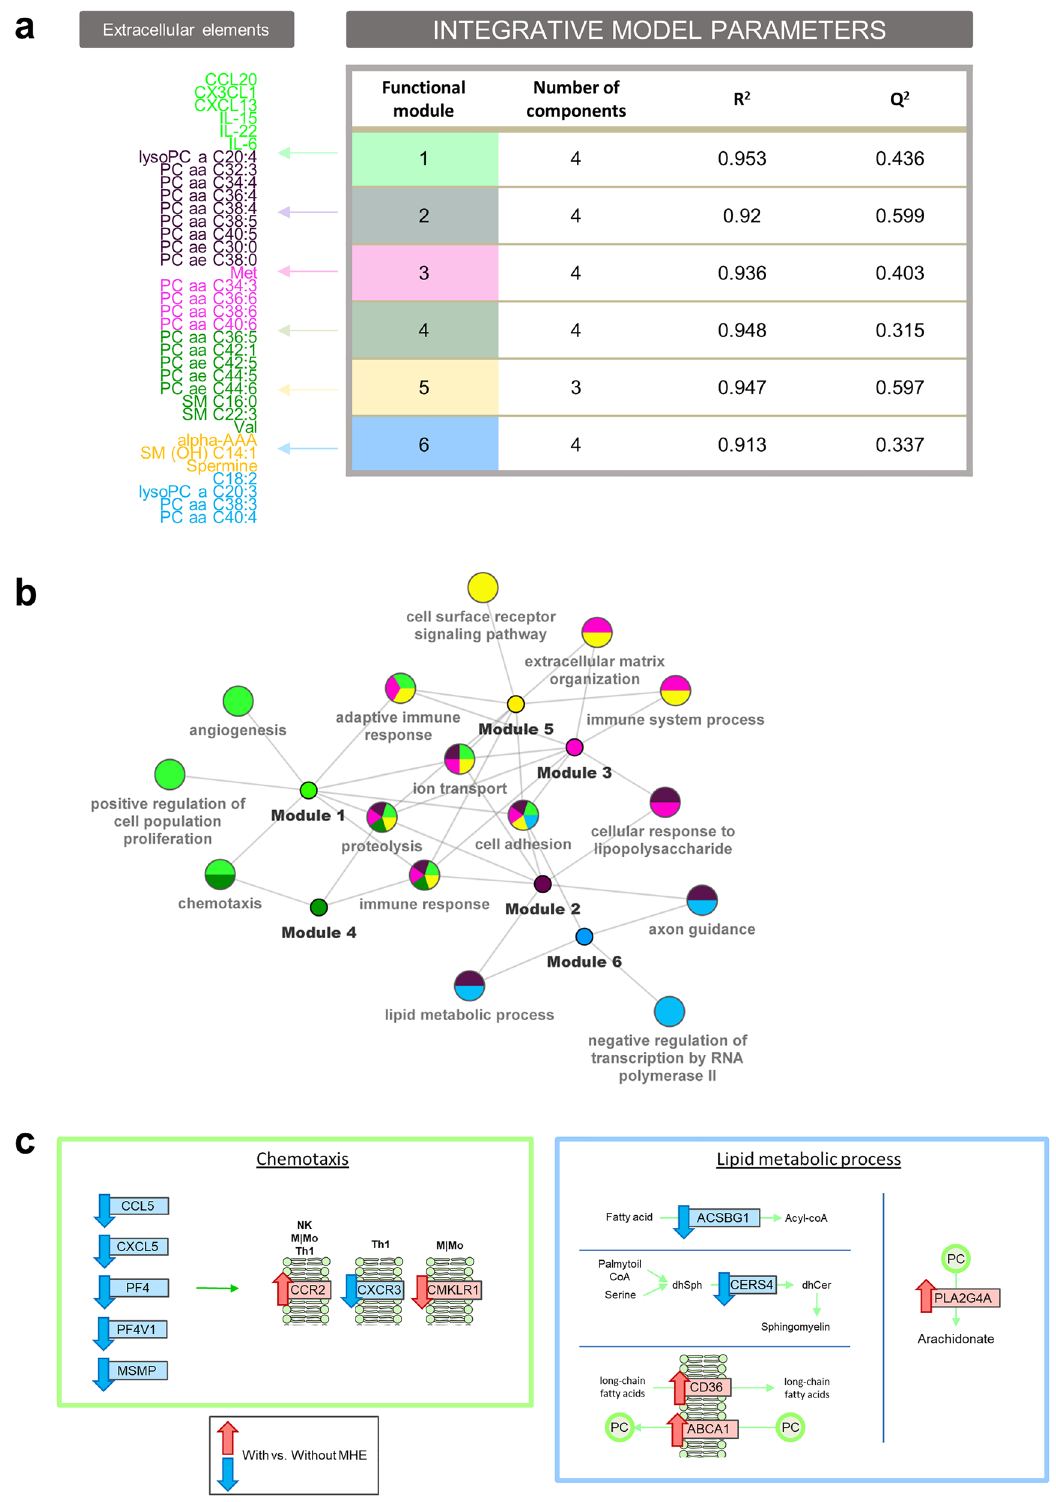
Figure 4. Multi-omic integration analysis and biological interpretation. ( a ) Results of PLS integrative models. R 2 : goodness of fit. Q 2 : goodness of prediction. ( b ) Multi-enrichment network. Every node is a selected significant GO biological process from the enrichment analysis in the PLS models. Edges denote links to the metabolites/cytokines modules where these pathways were found to be significant. ( c ) Some MHE altered GO terms at gene (rectangles) and metabolite (circles) level. Arrows indicate significant up (red) or down (blue) regulation in patients with versus without